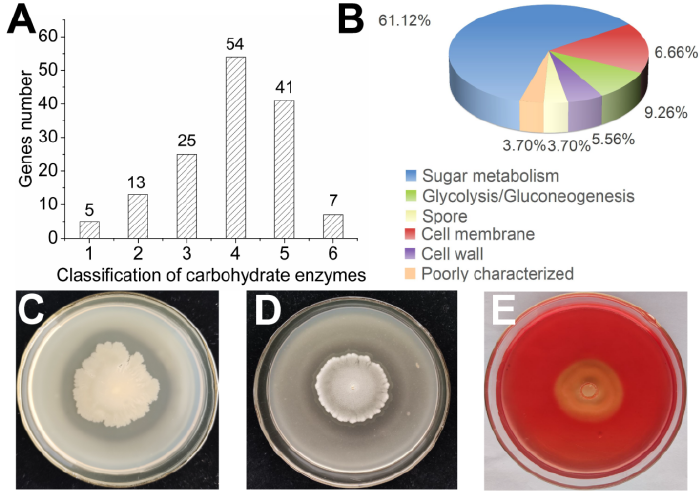
Figure 3. The classification and activities of hydrolytic enzymes of B. subtilis SF1. ( A ) The classification of carbohydrate enzymes in B. subtilis SF1 genome. ( B ) The function classification of the glycoside hydrolases in the genome of B. subtilis SF1. ( C – E ) The activities of protease, β -glucanase, and cellulase on the agar plate, respectively.